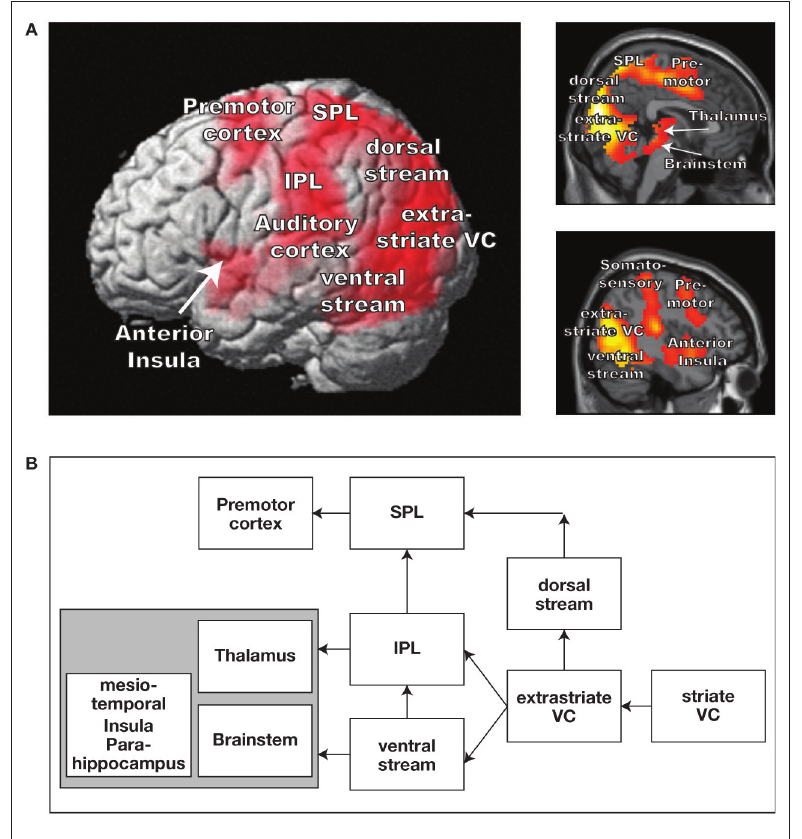
Figure 1 | Demonstration of brain areas that are more strongly activated during the presentation of a roller coaster scenario that evokes high presence versus low presence. (A) Increased hemodynamic responses overlaid on a three-dimensional (3D) rendered brain and two sagittal brain slices. (B) Schematic depiction of the stronger activated brain areas during the high presence